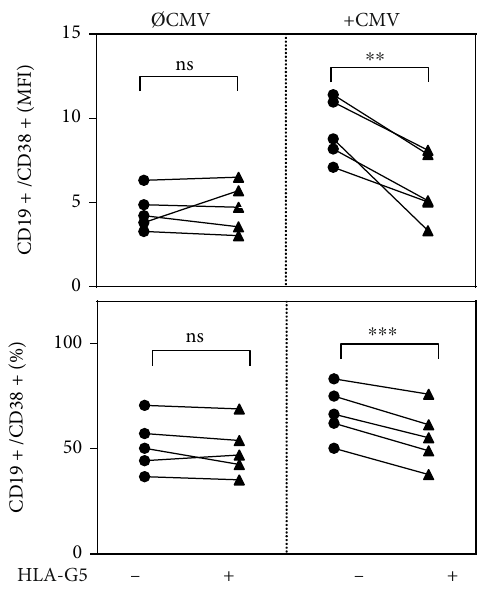
Figure 3: Human leukocyte antigen G5 (HLA-G5) signi fi cantly decreases the surface expression of CD38 in CD19 + splenic cells and decreases the proportion of CD19 + CD38 + cells in the total population of CD19 + cells after cytomegalovirus (CMV) antigen stimulation. The expression of CD38 is given as mean fl uorescence intensity index (MFI) and the proportion of CD19 + CD38+ cells in the total population of CD19 + cells (%). Statistical signi fi cance ( P < 0 : 05 ) was determined by two-tailed paired t -tests, ns: not signi fi cant; ∗∗ P < 0 : 01 ; ∗∗∗ P < 0 : 001